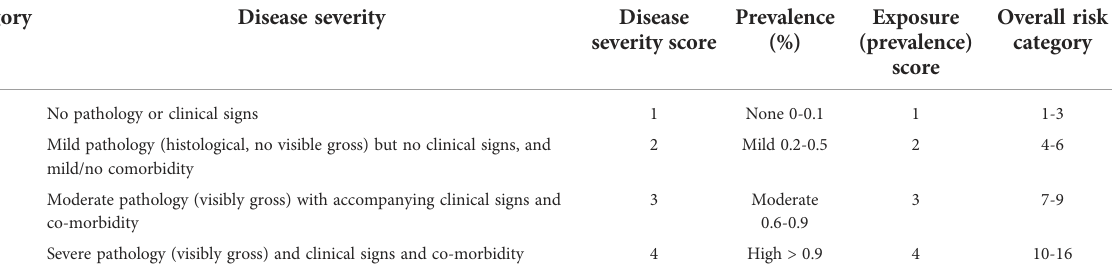
TABLE 3 Risk categories for disease severity and exposure probability.